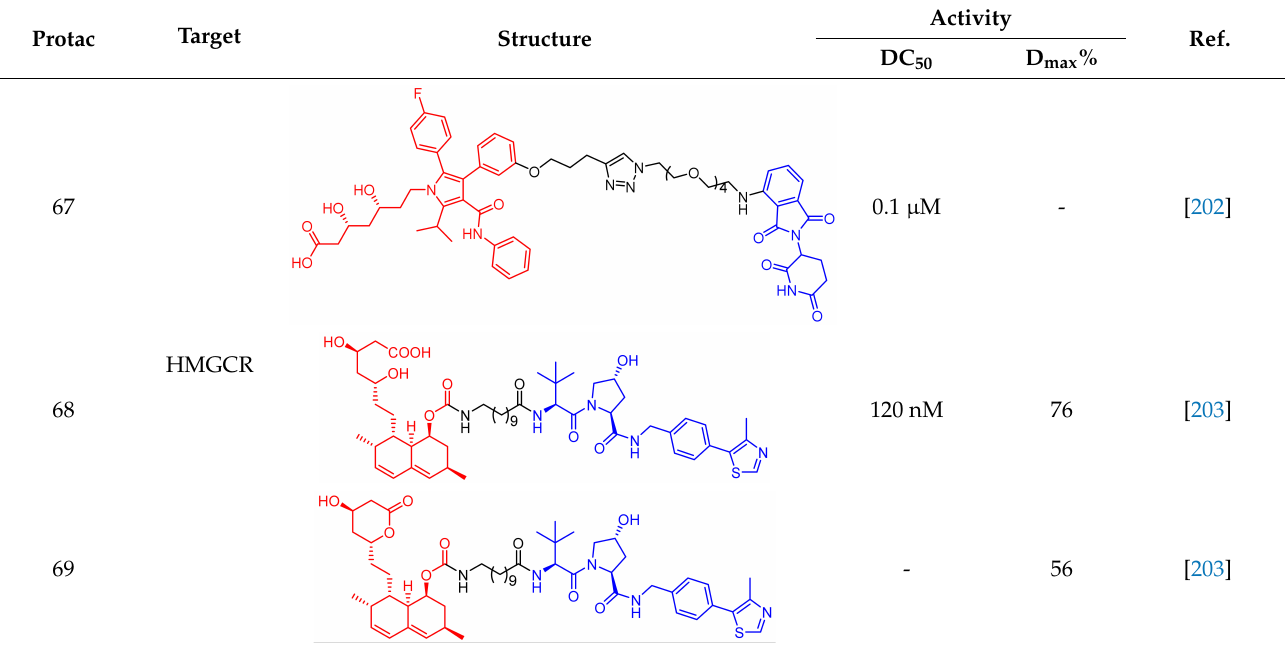
Table 4. Representative PROTACs for cardiovascular